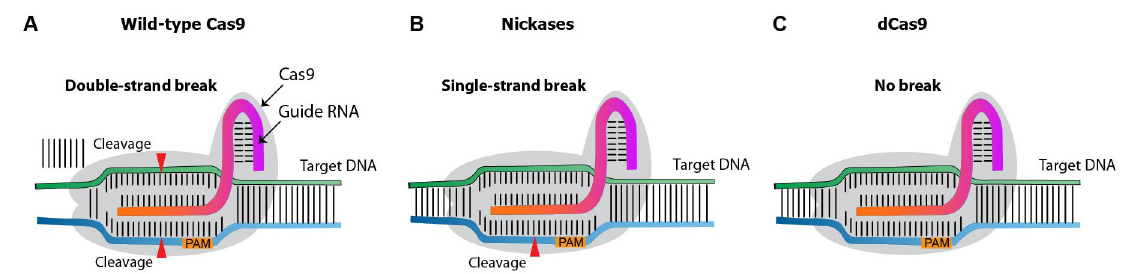
Figure 5. Diagram illustrating different types of Cas9 variants . ( A ), wild-type Cas9 nuclease. ( B ), Cas9 nickases that introduce a single-strand break at the target DNA. ( C ), catalytically inactive (dead) dCas9, which induces no breaks.